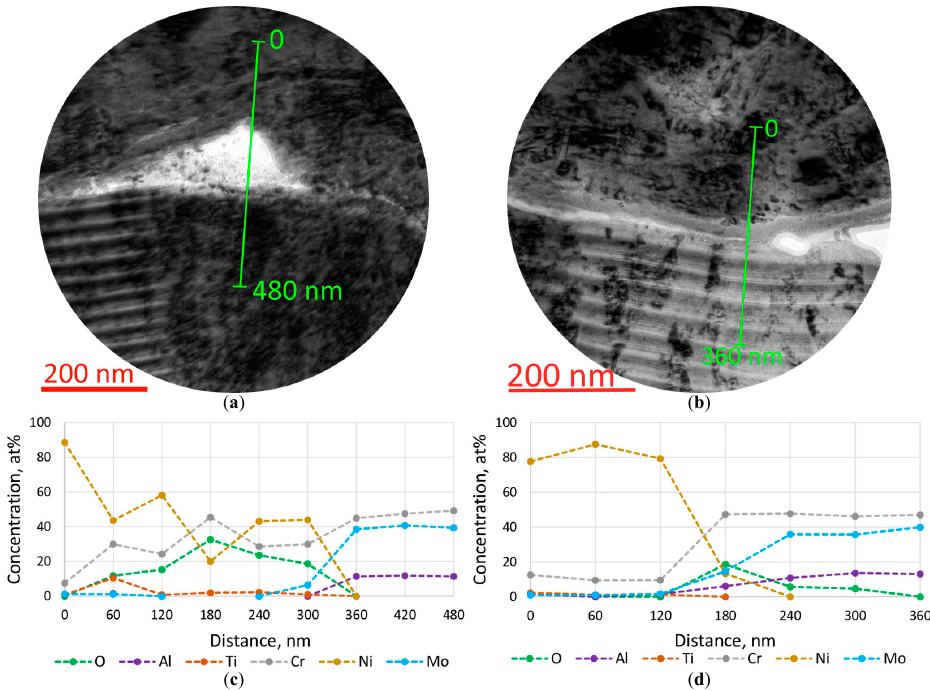
Figure 10. ( a ) Area A-1 and localization of the line for the study of elemental composition; ( b ) Area B-1 and localization of the line for the study of elemental composition, results of the study of change in elemental composition along lines in areas ( c ) A-1 and ( d ) B-1.